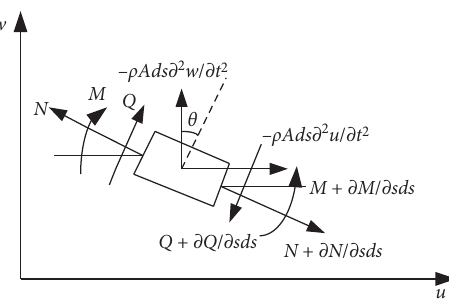
Figure 6: Force diagram of the